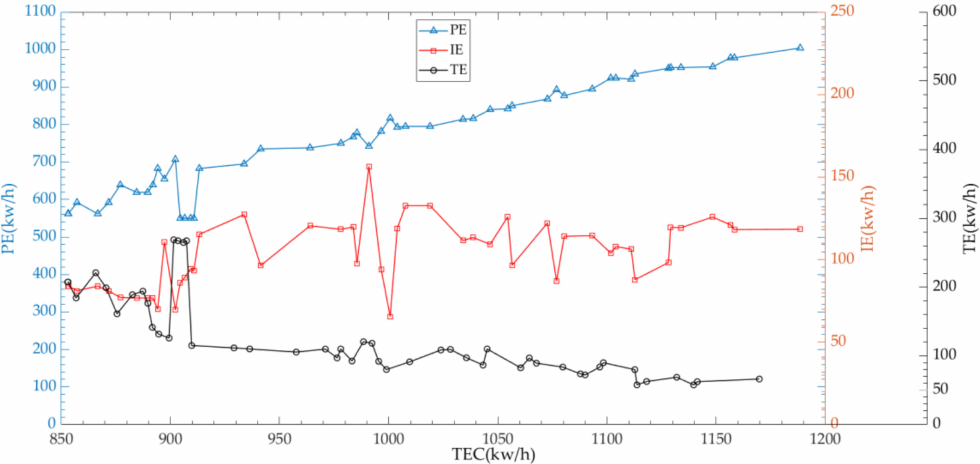
Figure 16. The distribution curves for three energy consumption